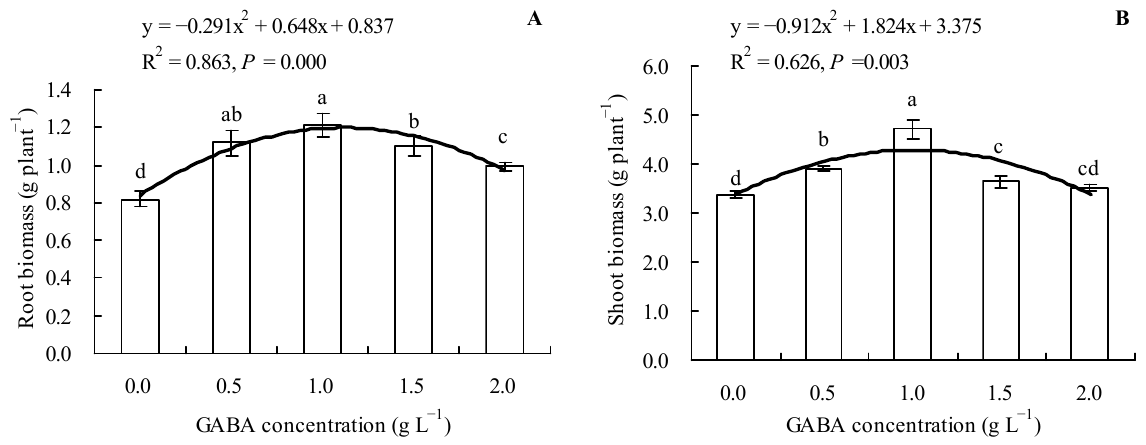
Figure 1. Biomass (dry weight) of loquat seedlings under the influence of gamma amino butyric acid. ( A ): Root biomass; ( B ): shoot biomass. Values are means ( ± SD) of three replicates. Different lowercase letters indicate significant differences among the treatments (Duncan’s Multiple Range Test, P < 0.05). GABA = gamma amino butyric acid.